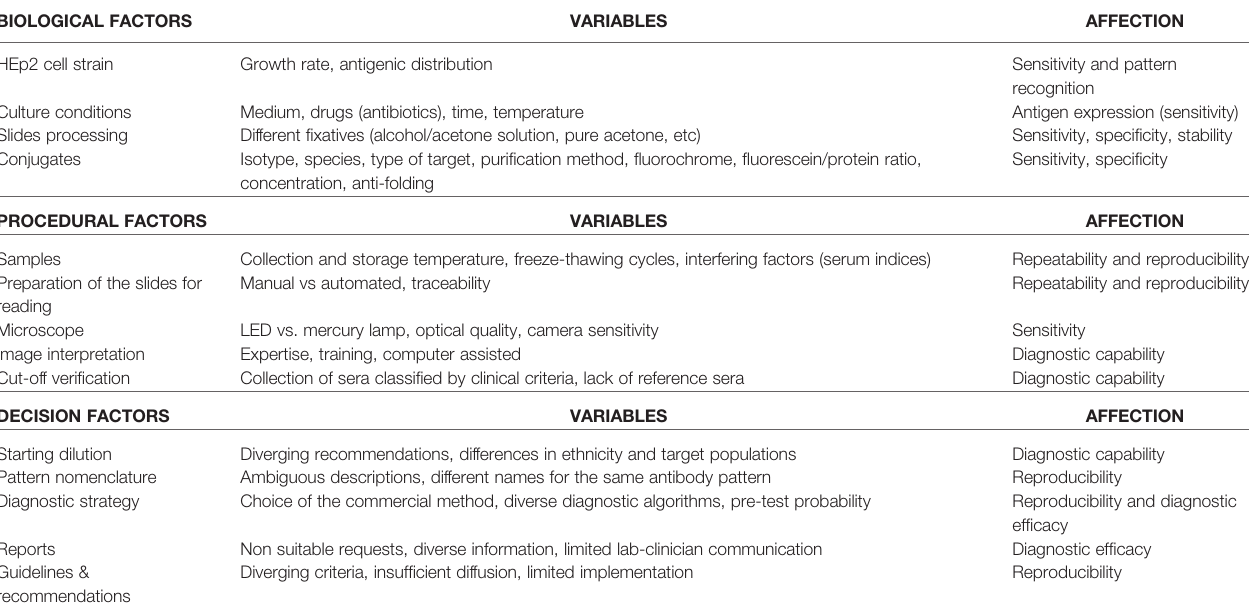
TABLE 1 | Main issues in the standardization of the ANA HEp-2 immuno fl uorescence assay. BIOLOGICAL FACTORS